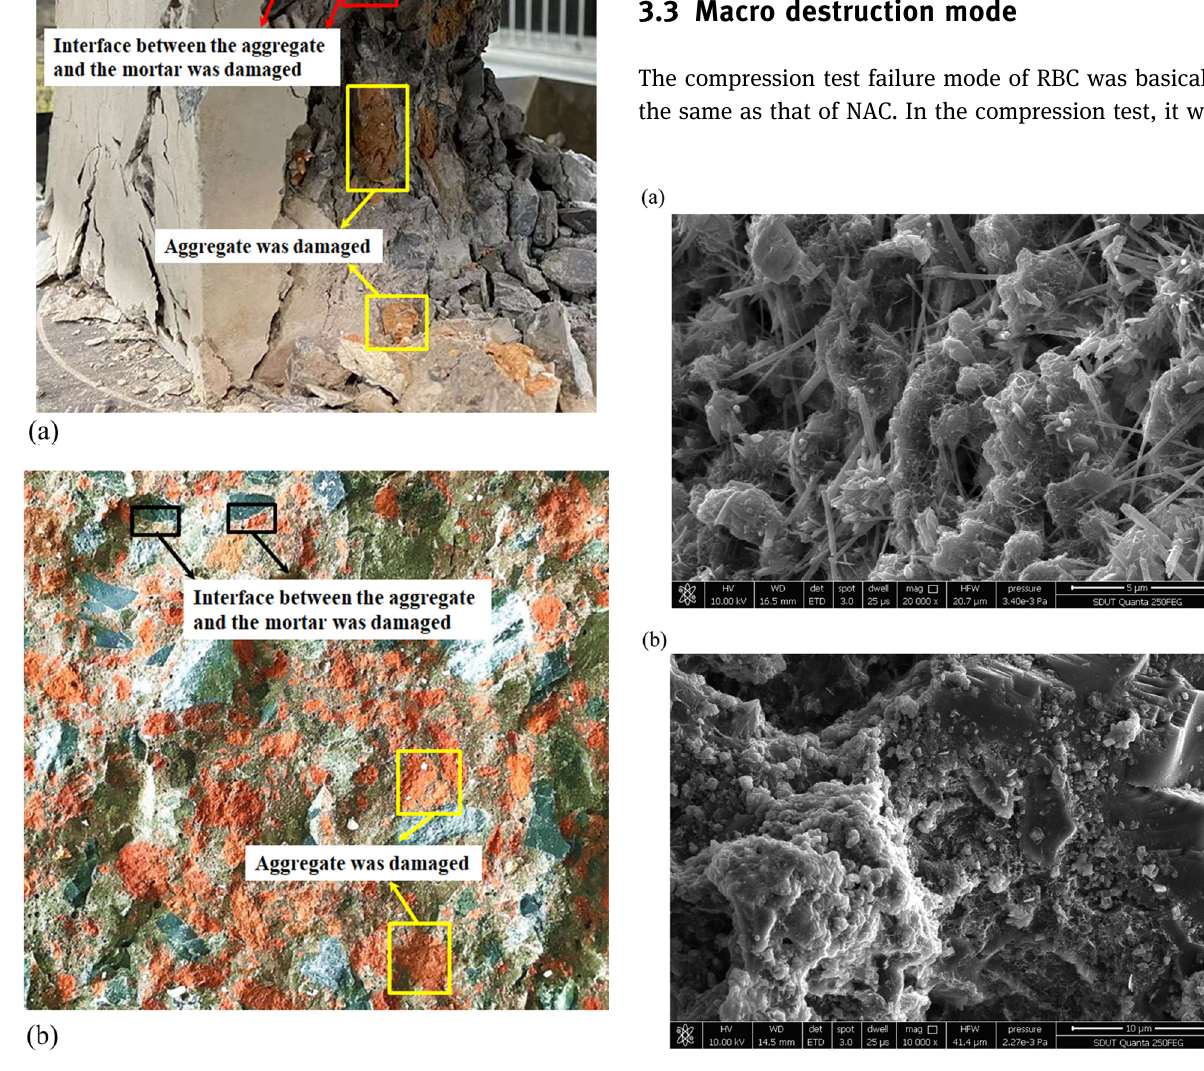
Figure 9: Destruction mode. ( a ) Compression test failure mode and ( b ) splitting tensile test failure mode.